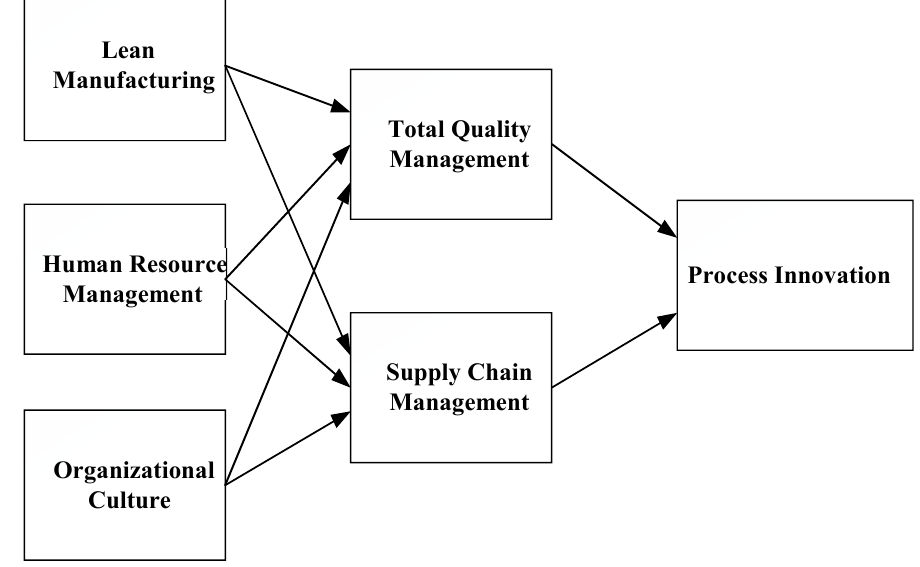
Figure 1. The proposed theoretical model.